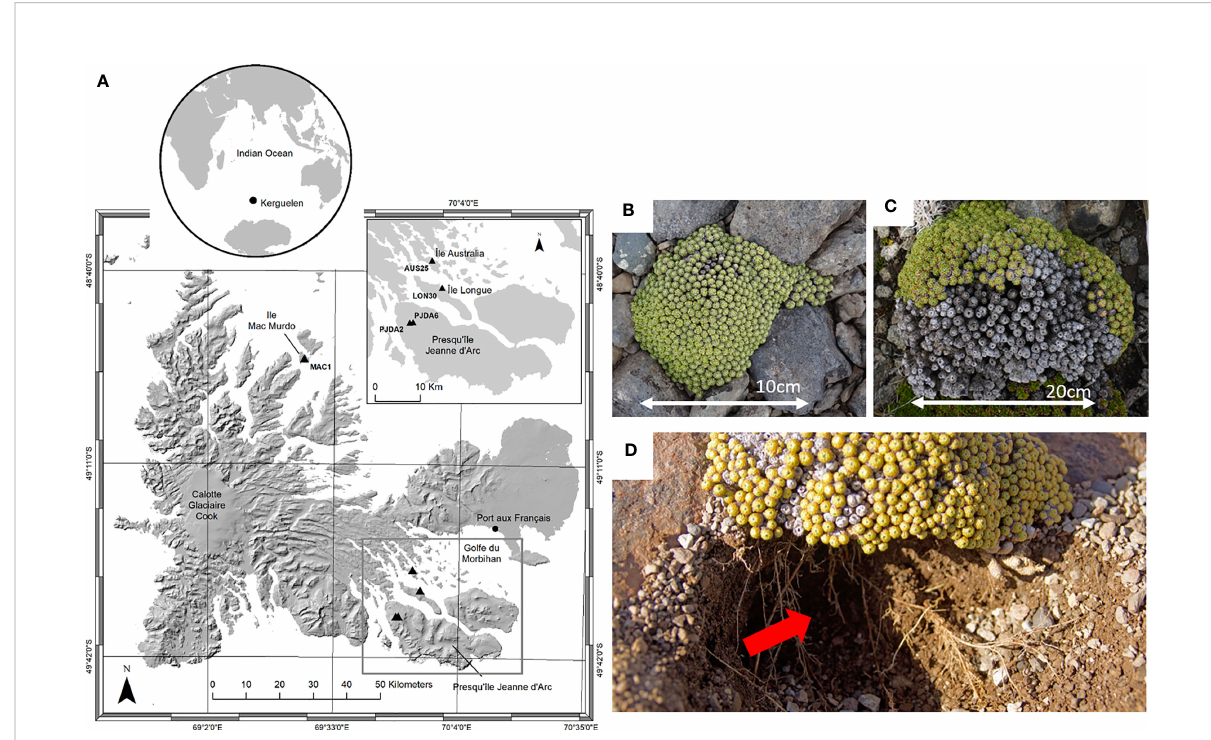
FIGURE 1 (A) Locations of the fi ve sampling sites (black triangles) in Kerguelen Islands on an altitudinal background (NASA – SRTM 30 M, 2005). The black dots indicate the research stations, labels indicate the site names and important features in the island, the grey rectangle shows the zoom into presented on the top right of the fi gure. Top right map: zoom into the Southeast part with four out of the fi ve studied sites. The map background comes from IGN 1/200 000 georeferenced with spatial adjustment ( D . Fourcy, unpublished). The small globe sets the Kerguelen Islands in the South Indian Ocean. ArcGIS 10.8.1. (B) Picture (from above) of Lyallia kerguelensis with only a few necrotic apices and (C) with more than half of the cushion necrotic. (D) Lyallia kerguelensis and its root system, location of the soil sampling (red arrow), the cushion shows